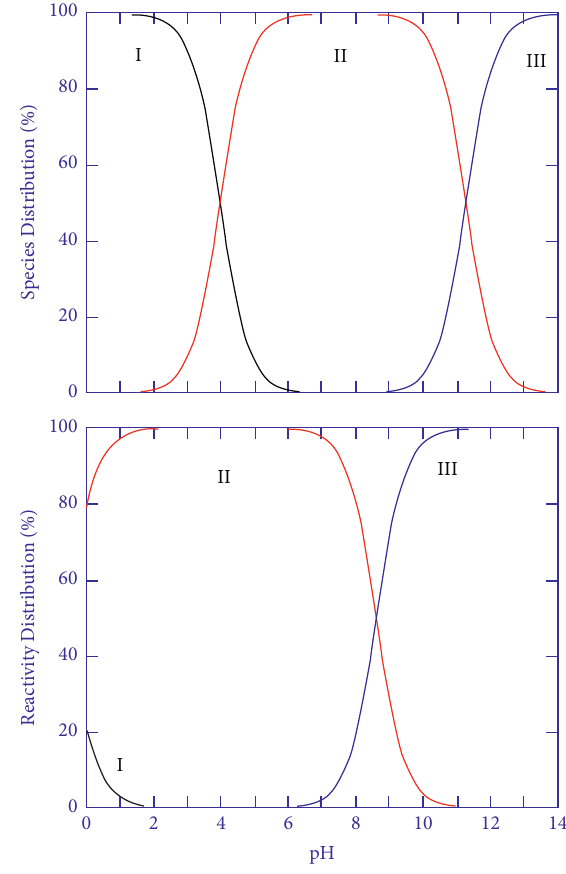
Figure 7: (a) Species of AA versus pH distribution diagram ( cf. Scheme 2). (b) Reactivity of AA species versus pH diagram